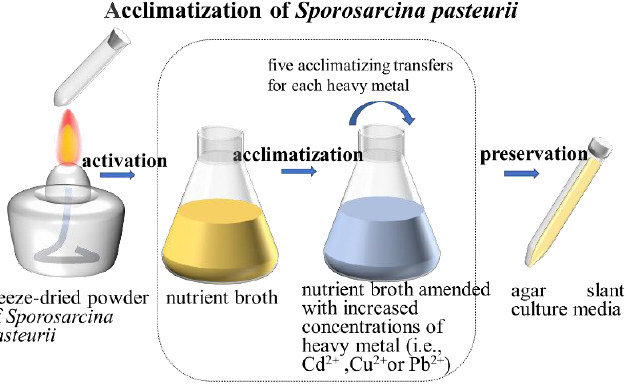
Figure 1. Procedure of S. pasteurii